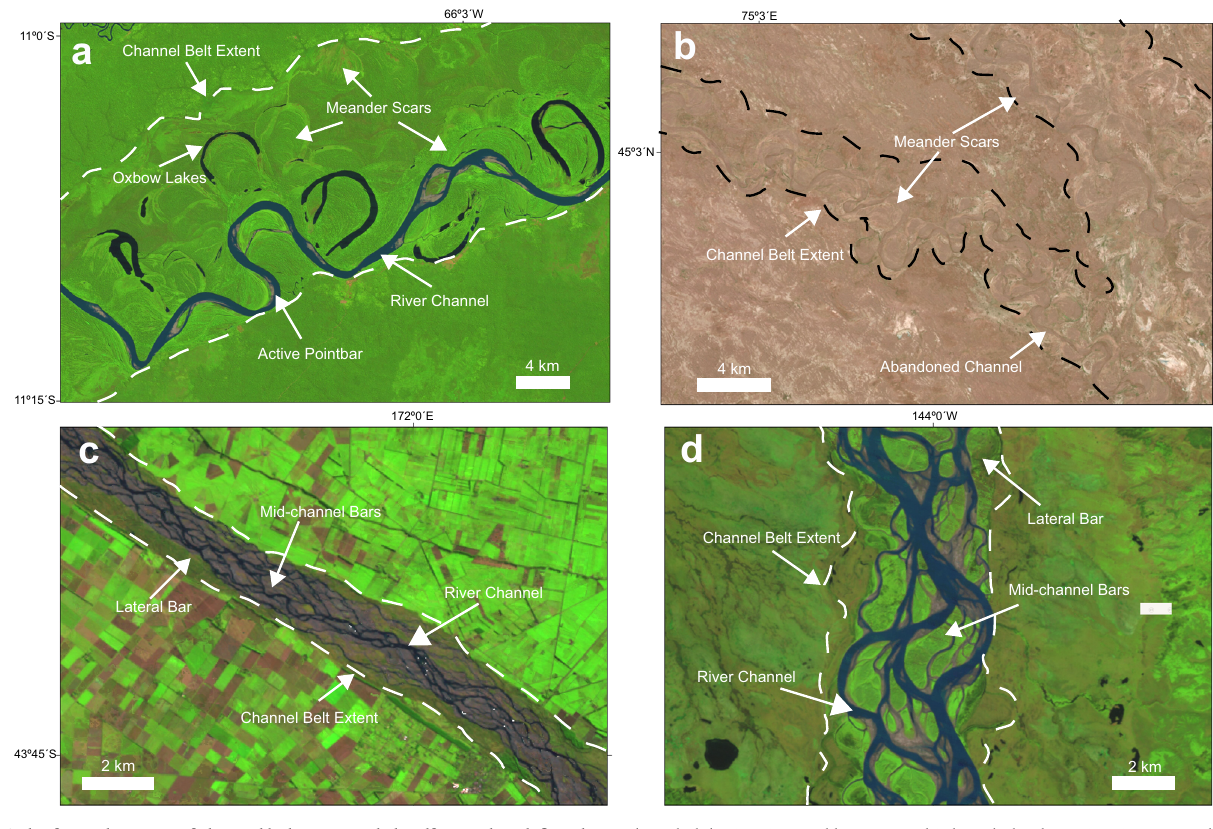
threaded Ili River in Kazakhstan, c multi-threaded Rakaia River in New Zealand, d multi-threaded Yukon River in Alaska, USA. Refer to main text for further detail. Landsat-8 images courtesy of the U.S. Geological